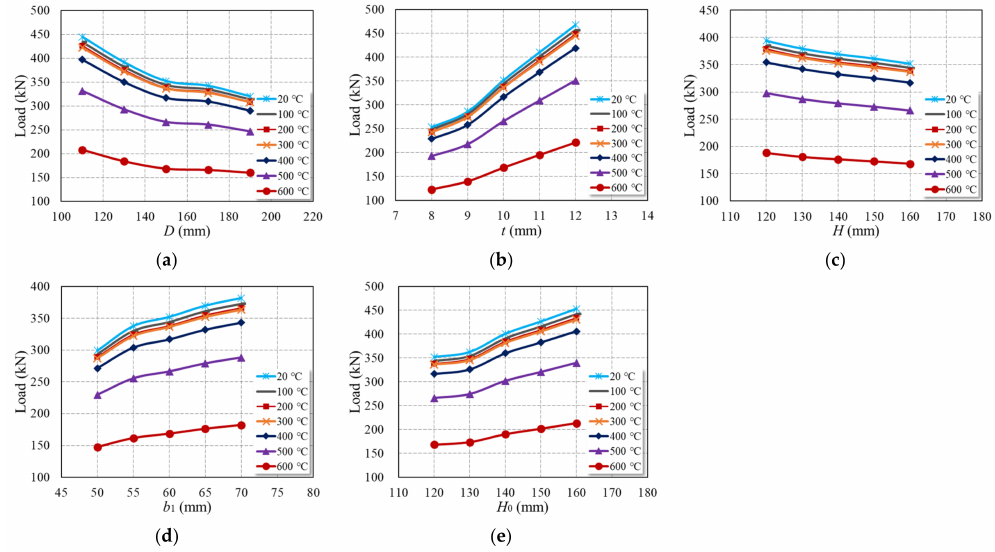
Figure 10. Effects of parameters on the load-carrying capacity of BBC joints under compression: ( a ) outer diameter of the tube; ( b ) thickness of the tube; ( c ) height of the tube; ( d ) width of the tubular beam; ( e ) height of the tubular